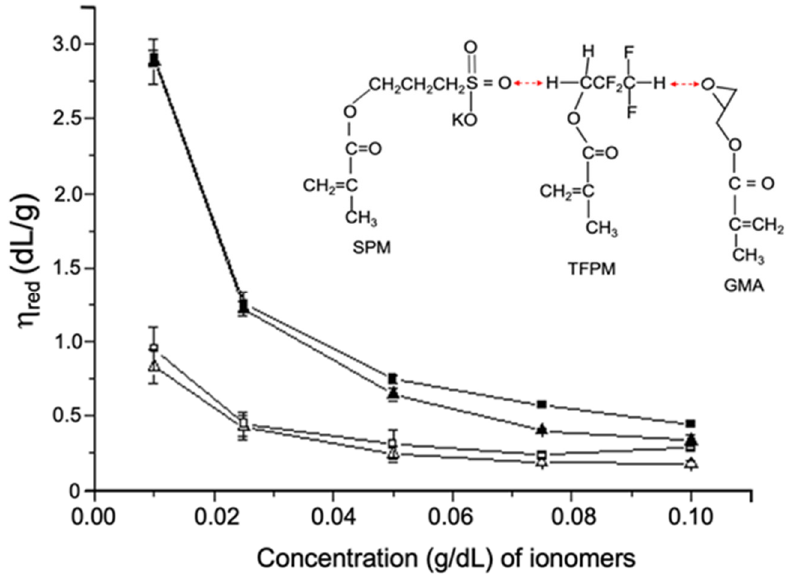
Figure 2. Reduced viscosity ( η red ) as a function of the random ionomers concentration at 22 · ◦ C: ionomer S0-10 in DMF ( ∆ ) and in a DMF/ethanol mixture ( v / v = 1) ( (cid:78) ); ionomer S20-10 in DMF ( (cid:3) ) and in a DMF/ethanol mixture ( v / v = 1) ( (cid:4) ). The inset shows the copolymerization mediating role of